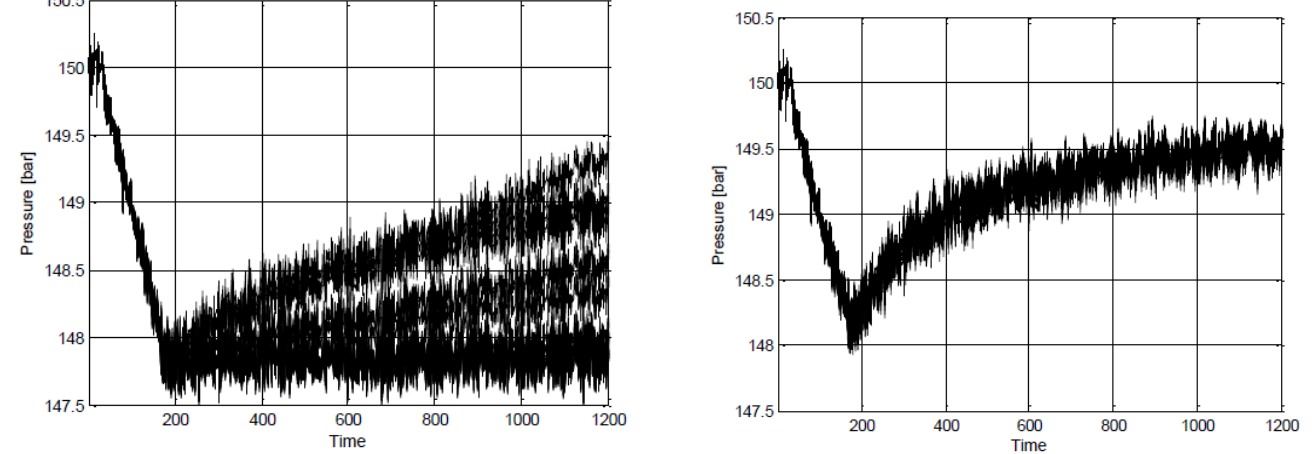
Fig. 20. Pressure profiles of trajectories belonging to cluster 3. Fig. 21. Pressure profiles of trajectories belonging to cluster 4.